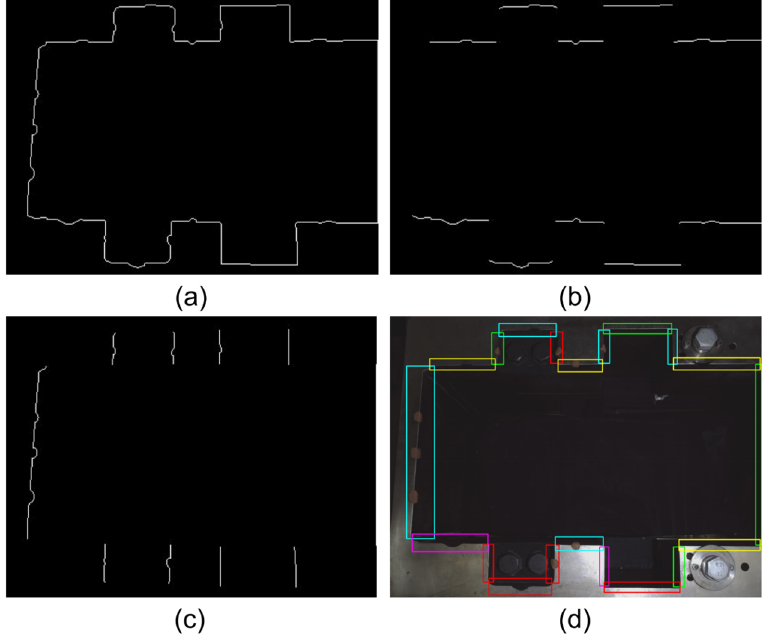
Figure 11. Results of contour separation and edge search box generation: ( a ) Original contour; ( b ) Contour points for horizontal edges; ( c ) Contour points for vertical edges; ( d ) Edge search